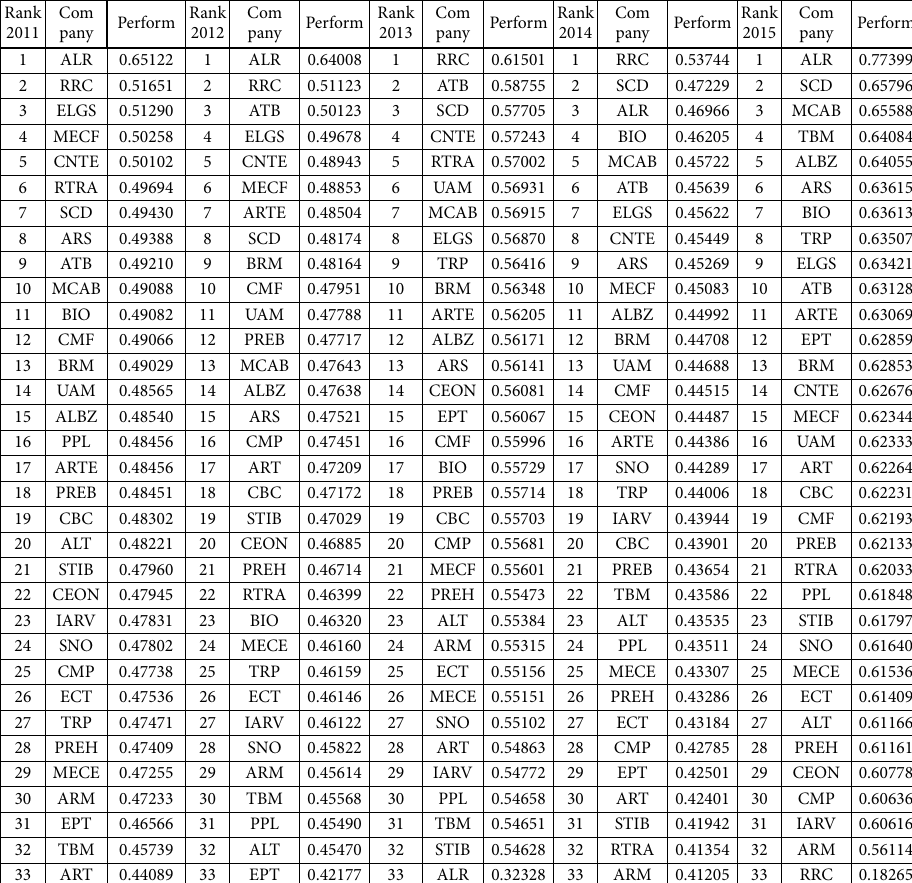
Table 8. Ranking of the companies in relation to VFP